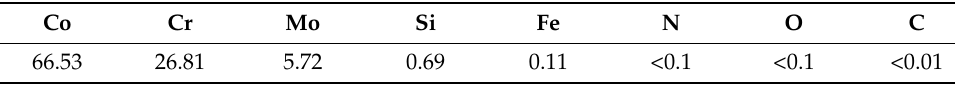
Table 1. Chemical composition of CoCrMo powder